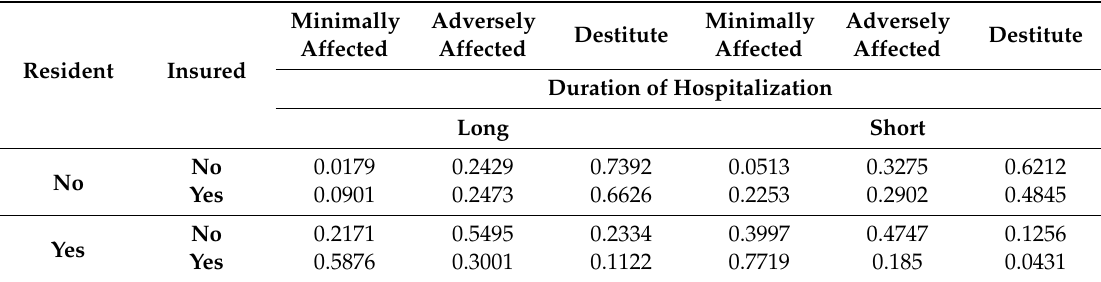
Table 9. Probabilities distribution on time of treatment and status of residency and insurance.